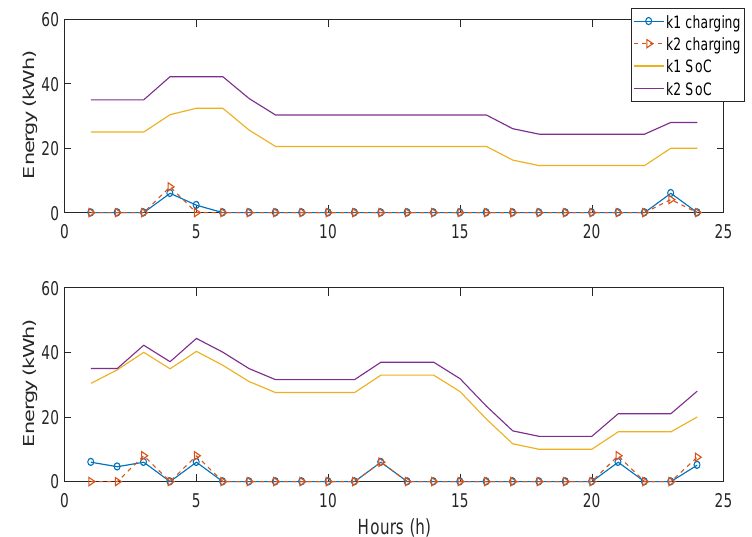
Figure 8. Illustrative results: Detailed hourly planning per vehicle for selected scenarios. Upper figure–scenario 1 and lower figure–scenario 3.